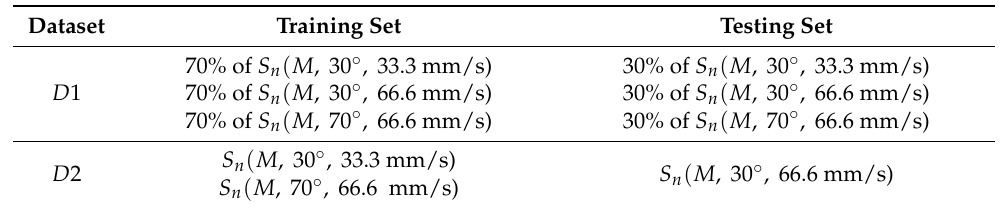
Table 3. Summary of the composition of training and testing set for datasets D1 and D2. Per material, D1 results in 210 signals for training and 90 signals for testing and D2 results in 200 and 100 signals for training and testing.